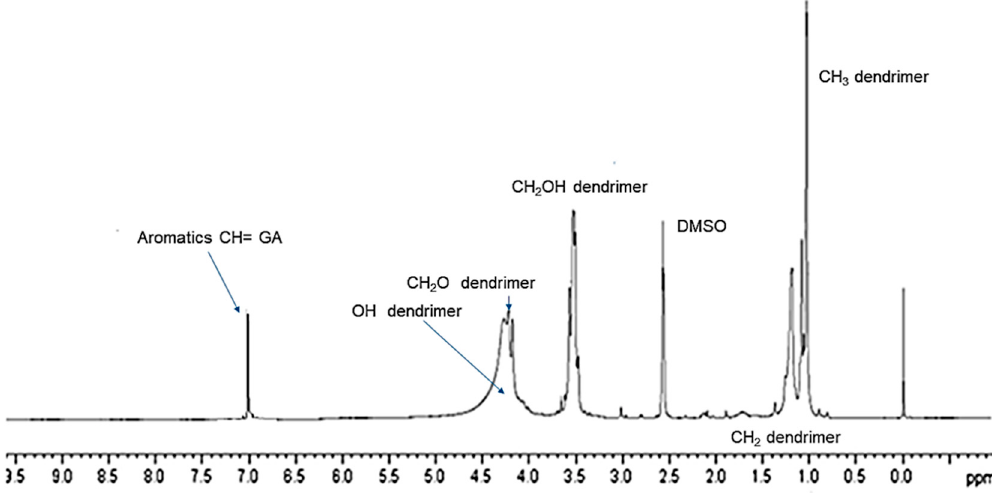
Figure 5. 1 H NMR (DMSO- d6 , 300 MHz) spectrum of GALD 7 .